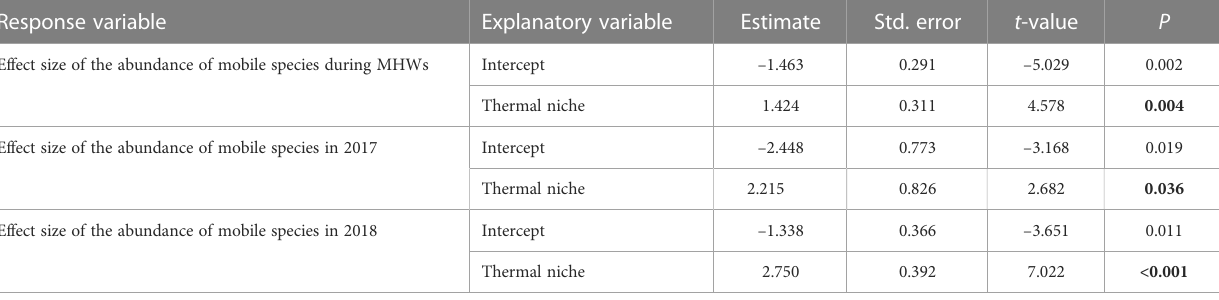
TABLE 5 Results of linear regression analysis testing how the effects of MHWs on the abundance of each mobile species of rocky intertidal organism (herbivorous mollusks and carnivorous invertebrates) for each period differ depending on thermal niche. Response